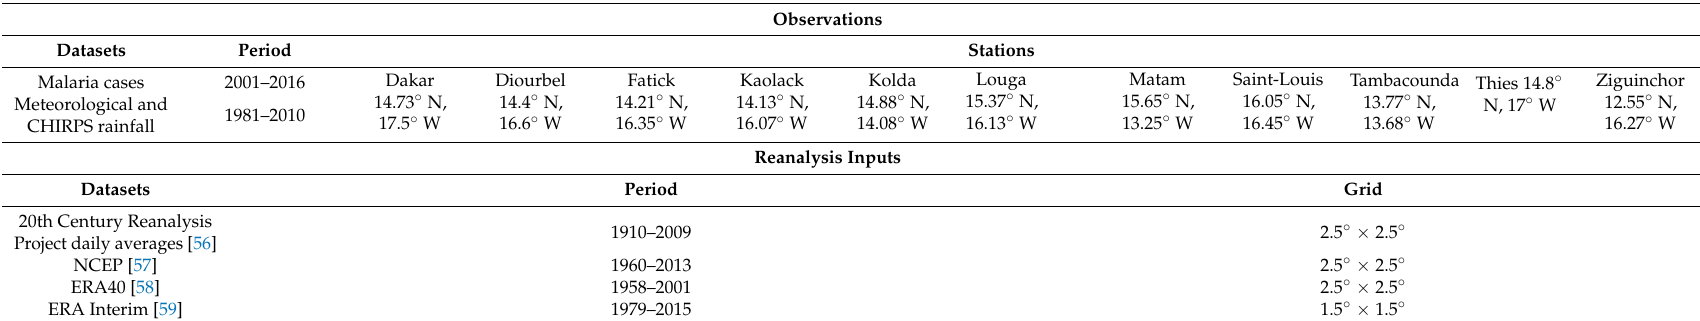
Table 1. Datasets and stations. This table summarizes the available datasets, time periods, the spatial resolution of gridded data, and the coordinates of the different